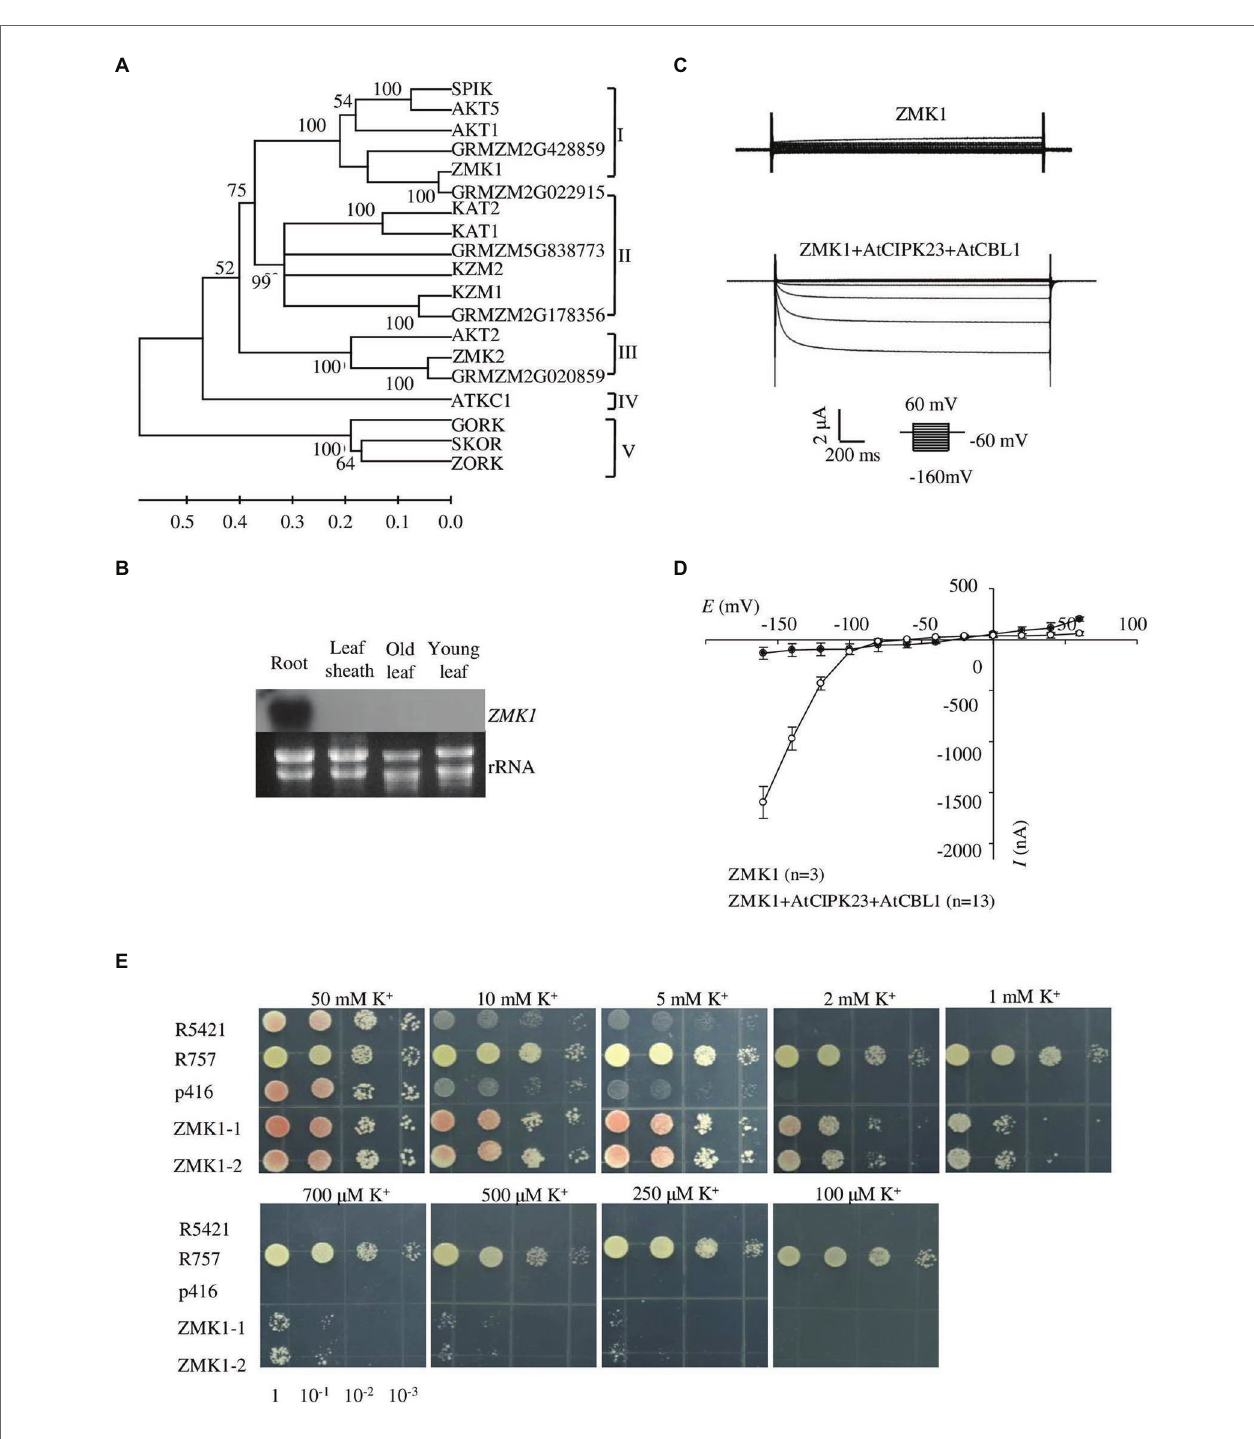
FIGURE 1 | Expression pattern and functional characterization of ZMK1. (A) The phylogenetic tree constructed using MEGA4 software based on alignments of all the Shaker-like potassium (K + ) channels from Arabidopsis and maize. The scale bar represents amino substitutions and the numbers on the tree nodes represent bootstraps from 1,000 replicates. (B) Northern analysis of ZMK1 in maize root, leaf sheath, old leaf, and young leaf during V3 stage. The RNA loading in each lane was 20 μ g. rRNA was used as a quantitative control. (C) Representative currents trace upon voltage clamp pulses from 60 to − 160 mV in oocytes expressing ZMK1 alone (upper panel) or ZMK1 with AtCIPK23 and AtCBL1 (bottom panel), in 96 mM K + solution at pH 7.2. Values are means ± SE ( n ≥ 3 oocytes). (D) Steady-state current-voltage ( I-V ) relationships for ZMK1 (black circles) alone or ZMK1 with AtCIPK23 and AtCBL1 (open circle) in 96 mM K + solution at pH 7.2.Values are means ± SE ( n ≥ 3 oocytes). (E) Functional characterization of ZMK1 in yeast. ZMK1 complement the K + uptake deficient phenotype of mutant yeast strain R5421 on AP medium containing different K + concentrations. Yeast strain R757 was used as a positive control. The p416 was empty